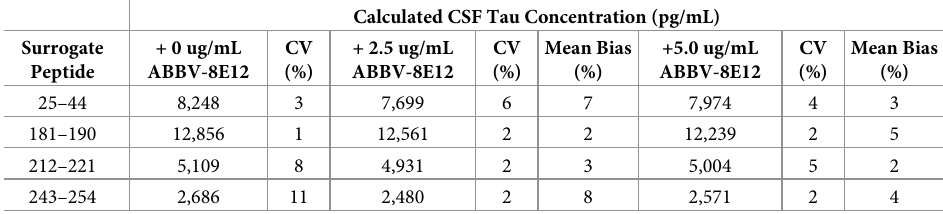
Reported values represent the mean calculated concentration and variance across one analytical run (n = 3